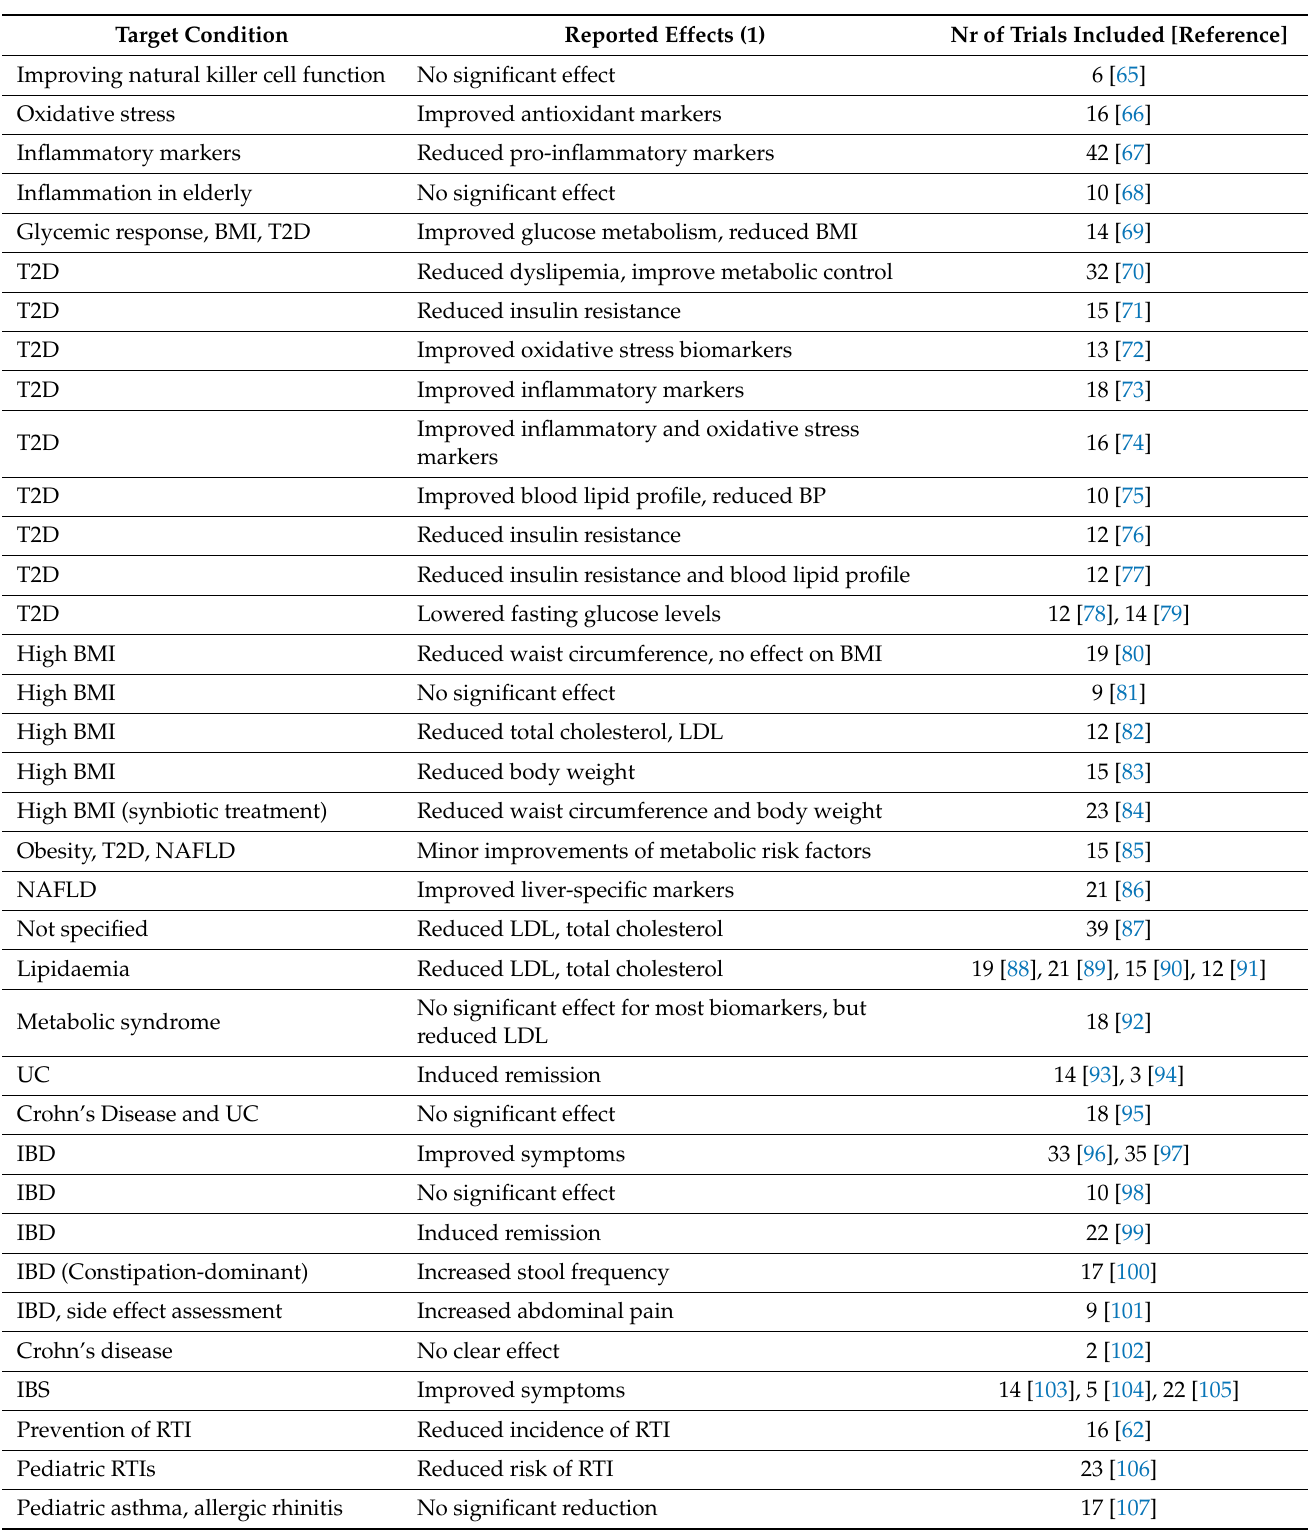
Table 1. Meta analyses published since 2016 assessing the activity of probiotics towards conditions related to the heart– lungs–gut